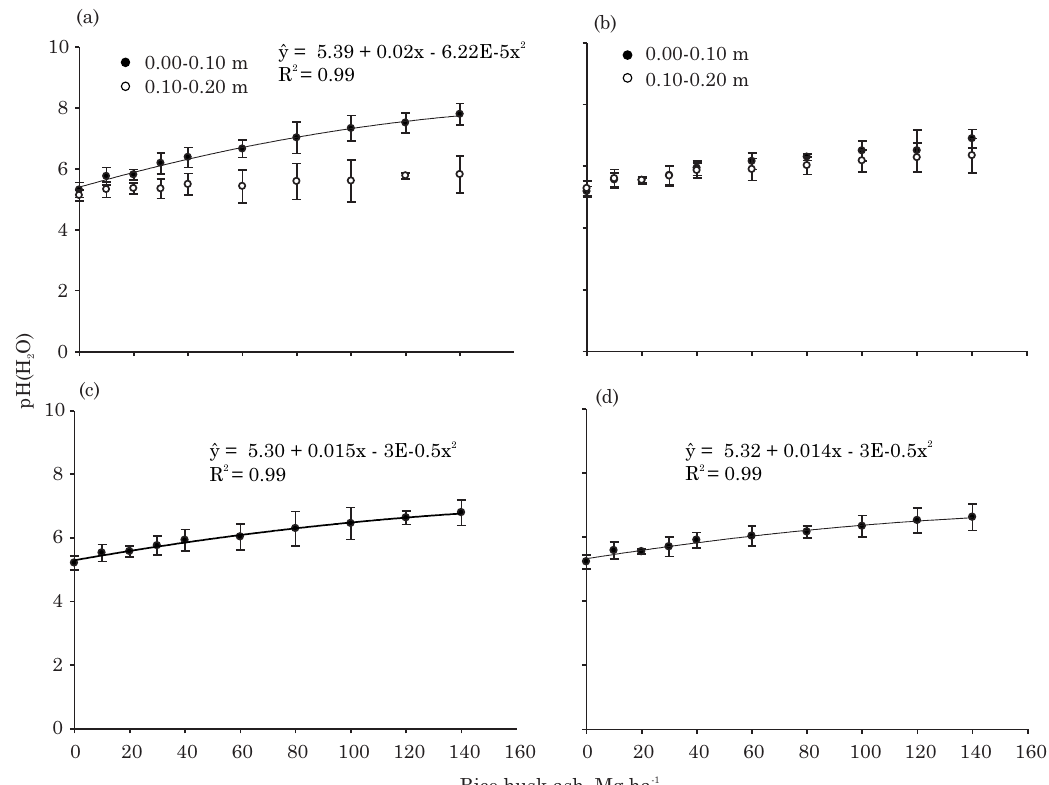
Figure 2. Relationship between dosage of rice husk ash (RHA) and soil pH(H 2 O) in the layers 0.00-0.10 and 0.10-0.20 m (a) 15 days after application of rice husk (daa); (b) 210 daa; (c) the average of 0.00-0.20 m 15 daa; and (d) the average of 0.00-0.20 m 210